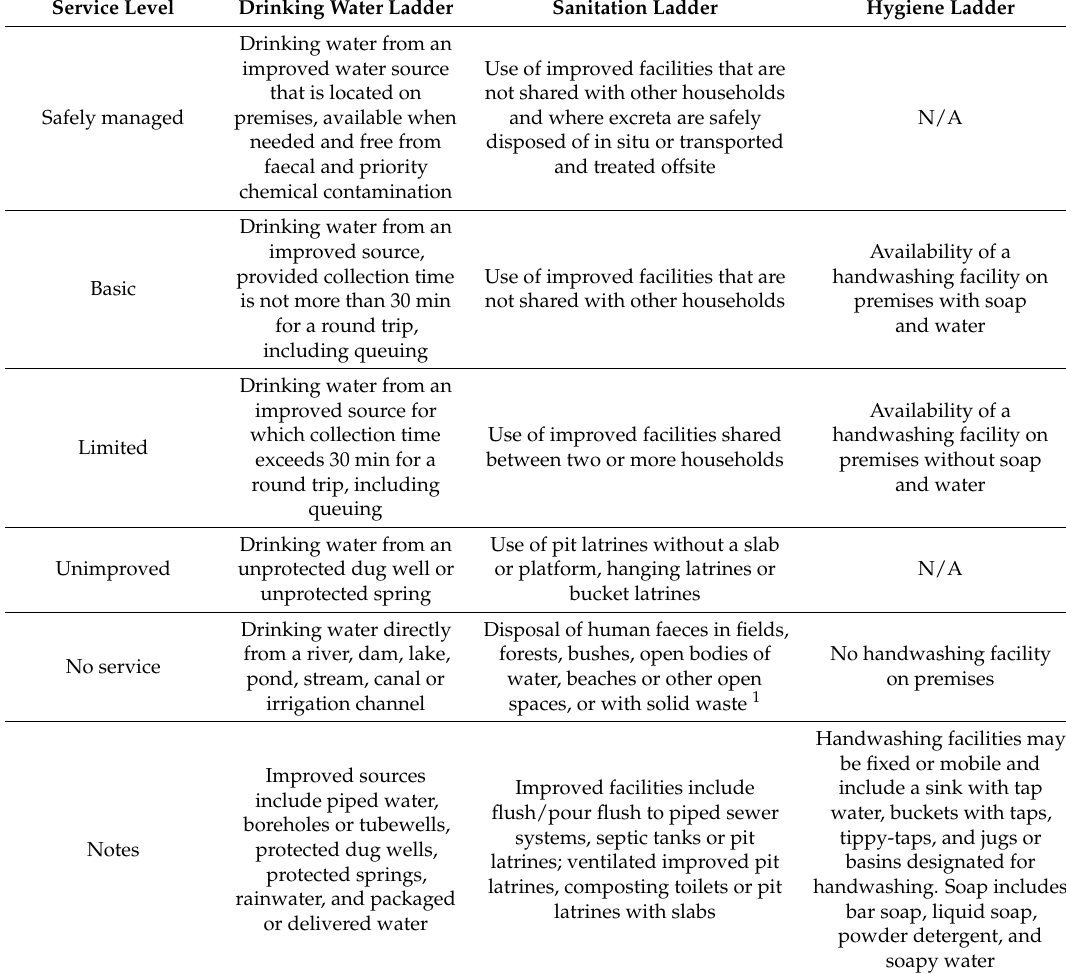
Table 2. Drinking water, sanitation and hygiene service ladders for household WASH